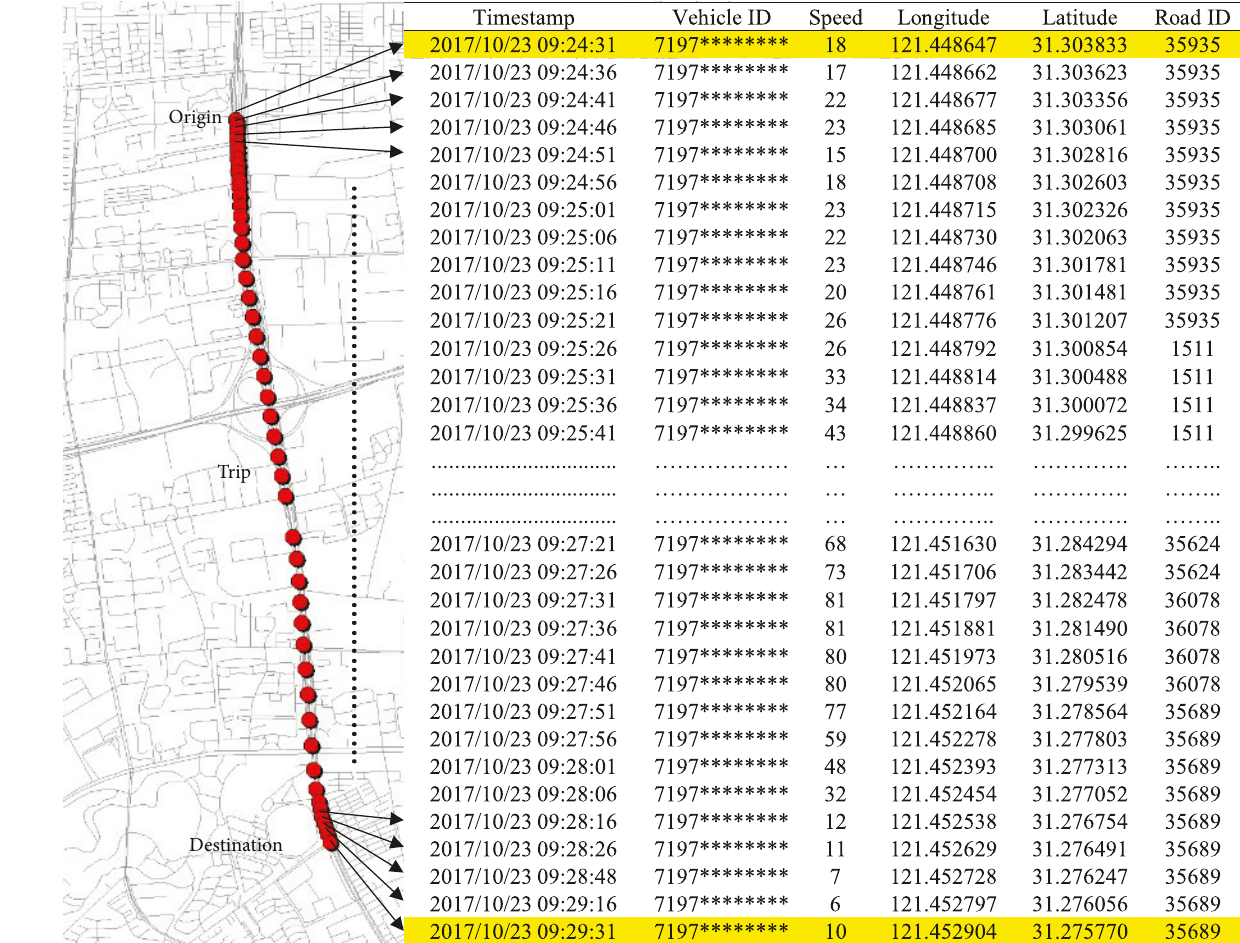
Figure 3: An example of vehicle trajectory